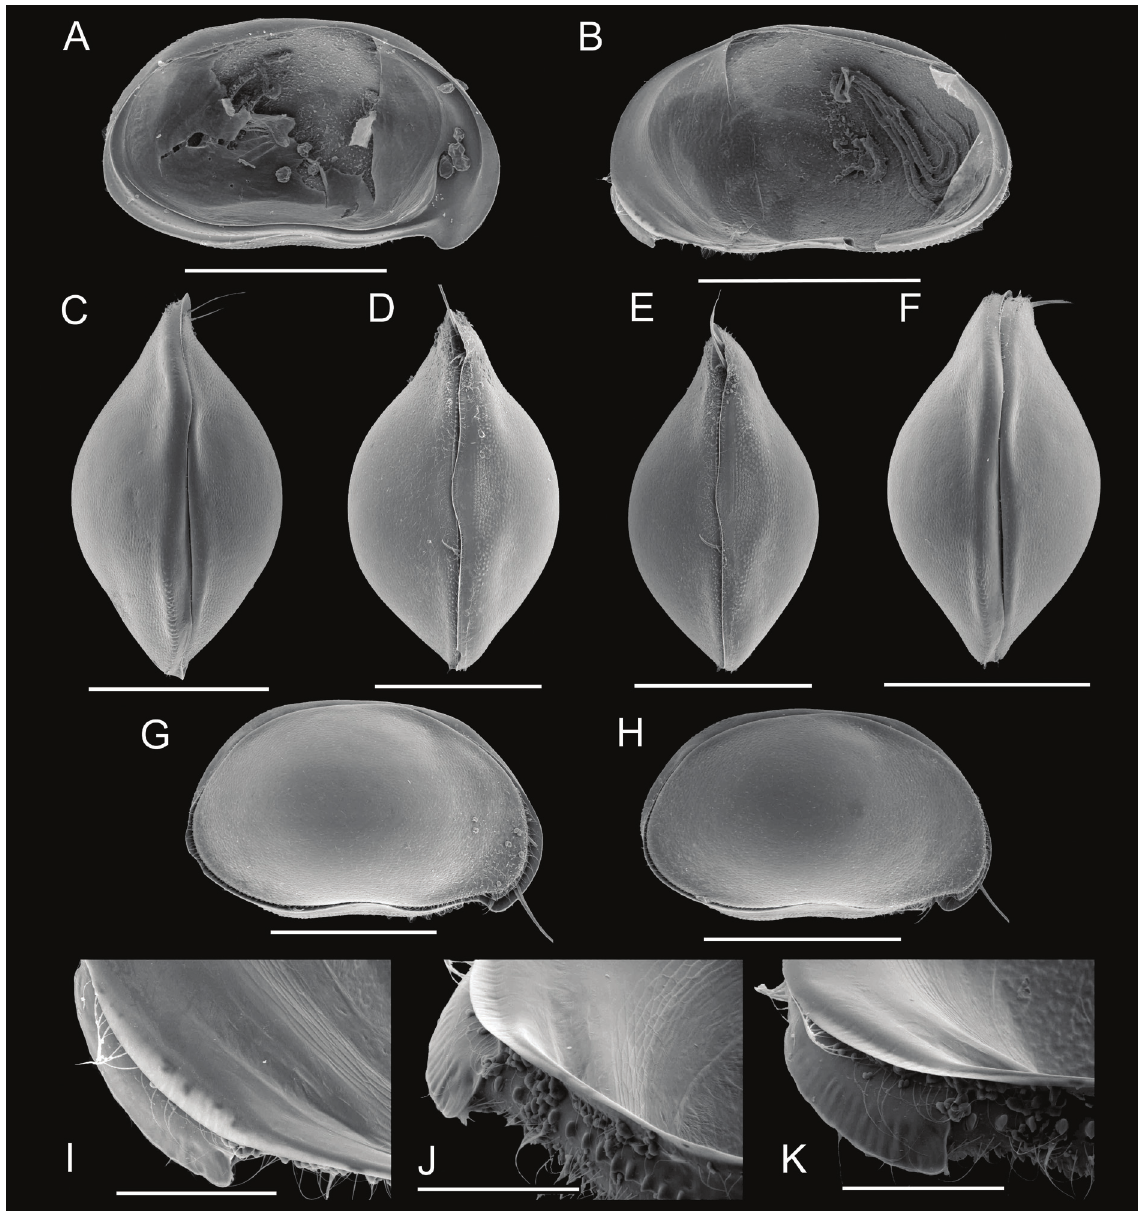
Fig. 18. Bennelongia cuensis sp. nov. (all from pan near Cue, type locality). A . LVi (♂, WAM.C49408). B . RVi (♂, Idem). C . Cp dorsal (♀, specimen lost). D . Cp ventral (♀, same specimen lost). E . Cp ventral (♂, WAM.C49410A). F . Cp dorsal (♂, Idem). G . CpRL (allotype ♀, WAM.C49407). H . CpRL (♂, WAM.C49410B). I . RVi (detail anteriorly, ♂, WAM.C49408). J . RVi, detail anteriorly (tilted ♂, Idem). K . RVi (detail anteriorly, tilted ♂, Idem). Scales: A-H = 1000 µm; I-K = 200